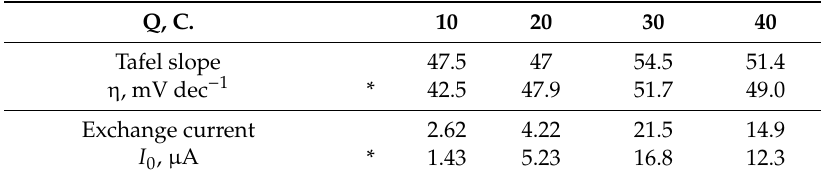
Table 2. Electrocatalytic activity parameters of the electrodeposited MoS 2 films from electrolytes containing MoS 42 − , and MoS 42 − + NaH 2 PO 2 (denoted with *). Q, C.